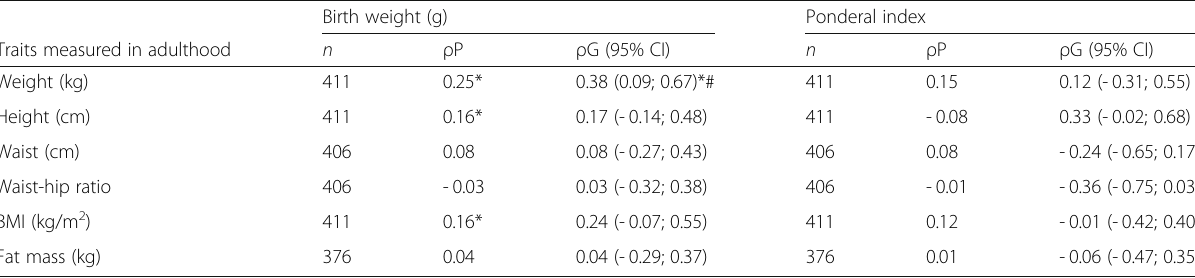
Table 6 Phenotypic and genetic correlations between measures of body composition at birth and in adulthood Birth weight (g) Ponderal index Traits measured in